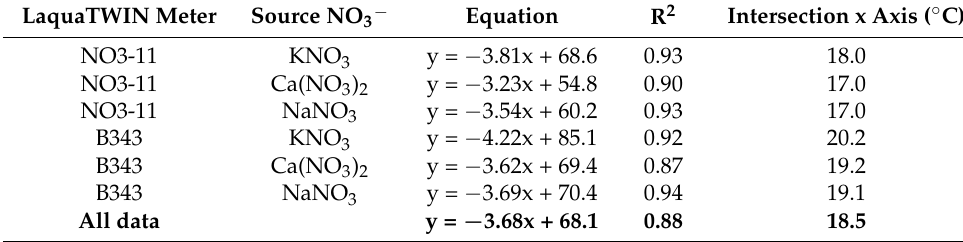
Table 1. Summary of linear regression equations, R 2 values, and the value of the intercept with the x-axis for the relationship of the relative difference between the [NO 3 − ] measured with an ISE meter and the known [NO 3 − ], and sample temperature. Data are presented for each combination of ISE meter (LAQUAtwin NO3-11 and LAQUAtwin B343) and source of NO 3 − , in the sample temperature range of 5–25 ◦ C. The known [NO 3 − ] were 6, 12 and 18 mmol L − 1 . In the regression equations, y is the percentage value of the deviation from the known value, i.e., ((measured [NO 3 − ] with ISE meter minus (known [NO 3 − ]))/known [NO 3 − ] and x is sample temperature in ◦ C. LaquaTWIN Meter Source NO 3 − Equation R 2 Intersection x Axis ( ◦ C) NO3-11 KNO 3 y = − 3.81x + 68.6 0.93 18.0 NO3-11 Ca(NO 3 ) 2 y = − 3.23x + 54.8 0.90 17.0 NO3-11 NaNO 3 y = − 3.54x + 60.2 B343 KNO 3 y = − 4.22x + 85.1 B343 All data y = − 3.68x + 68.1